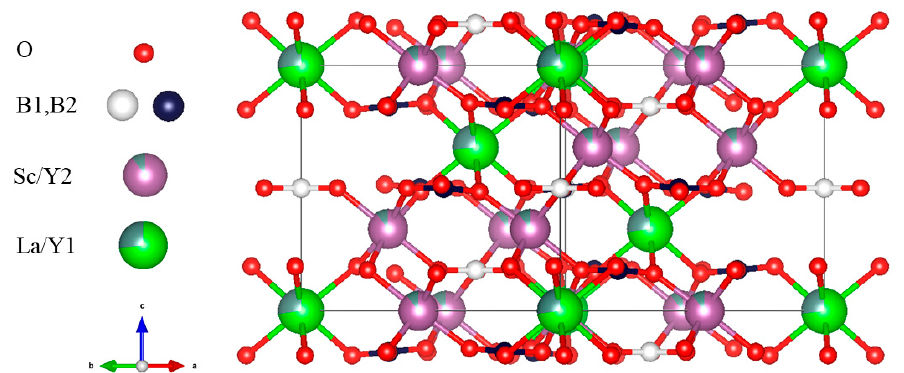
Figure 9. LYSB crystal structure. (Reprinted with permission from ref. [13], copyright 2019 American Chemical Society).